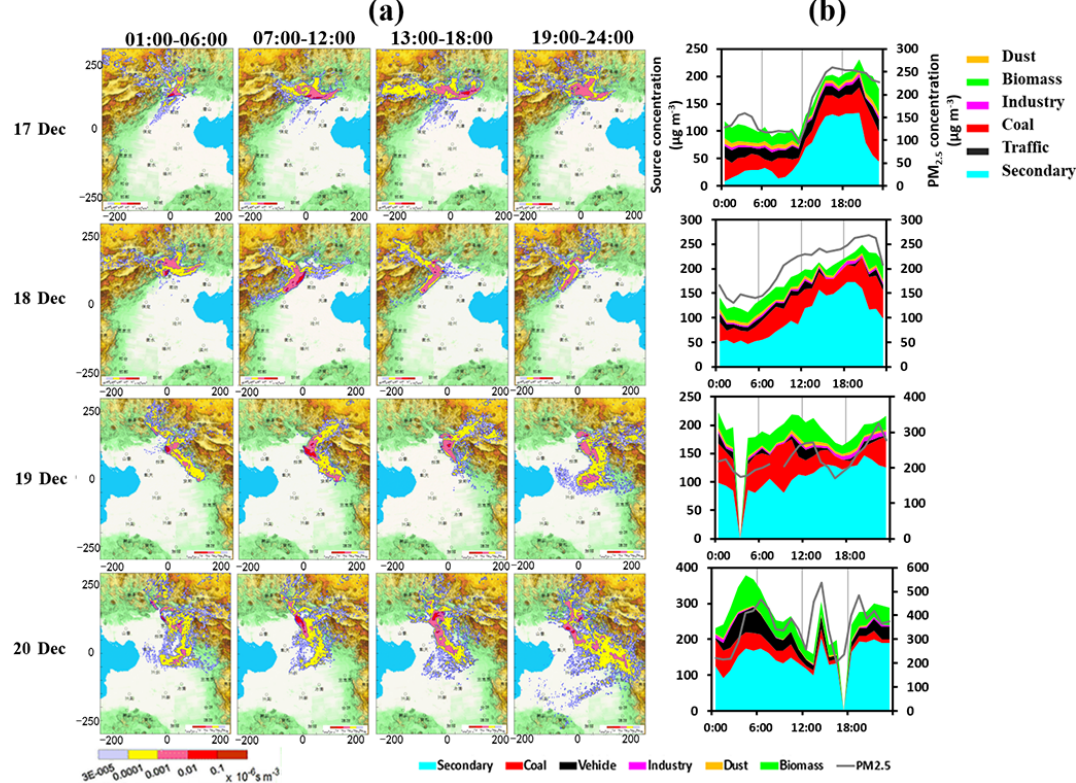
Figure 7. (a) Source regions by the footprint model and (b) daily source apportionment results by PMF in